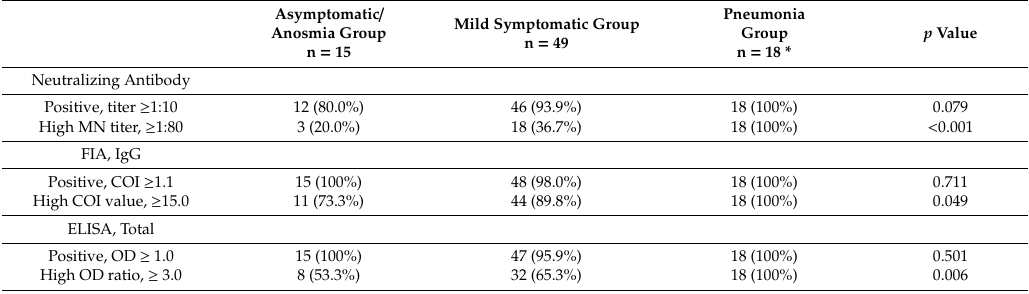
Table 2. Neutralizing antibody production and serologic tests for asymptomatic to severe COVID-19